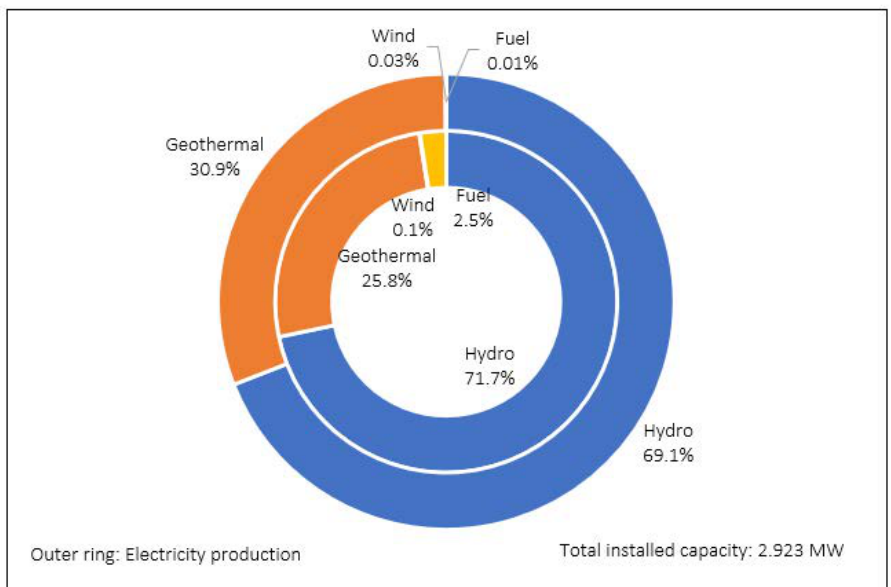
Figure 2. Installed electrical capacity and electricity production in power plants by source in 2019 [74]. In terms of electricity consumption, conventional users, such as households, make use of 17% (equivalent to 3,375,430 MWh), while heavy industry accounts for 78% (equivalent to 15,146,410 MWh), of total electricity consumption. Within heavy industry, aluminum smelting plants account for 82% of electricity consumed (see Figure 3).